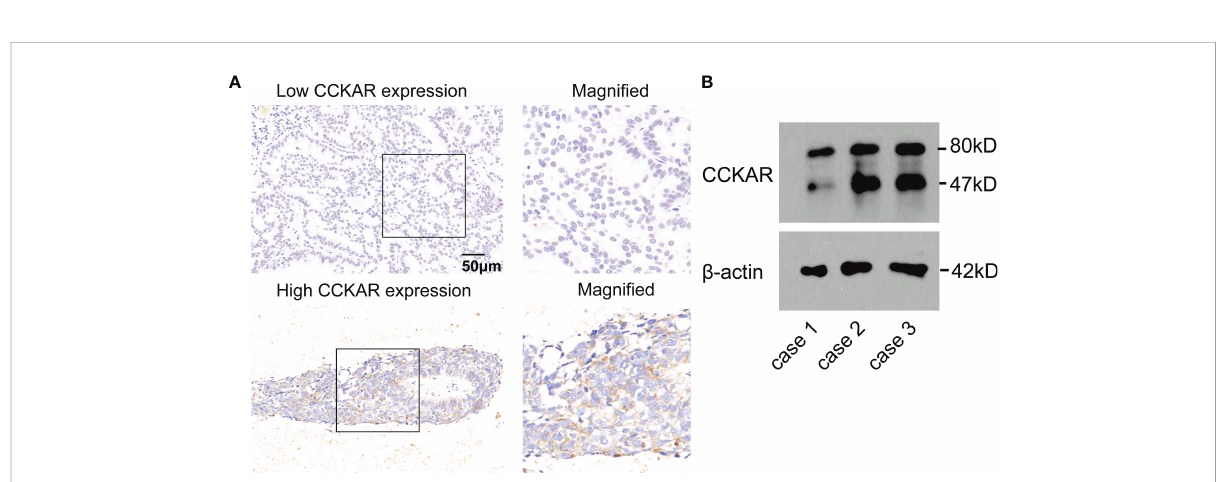
FIGURE 3 CCKAR expression in BM from NSCLC. (A) The expression of CCKAR in BM from NSCLC was detected by IHC. Patients with BM from NSCLC were divided into subsets with low or high CCKAR expression. (B) The expression of CCKAR in 3 BM tissues was detected with Western